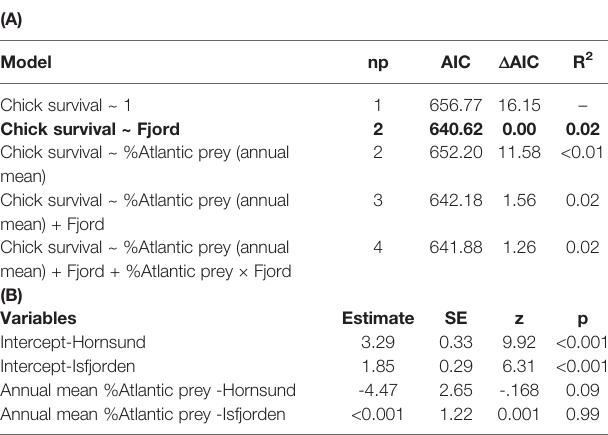
TABLE 6 | Effect of the individual proportion of Atlantic prey in the little auk (chick) diet on chick survival (to 15 days) in two western Svalbard fjords (Hornsund and